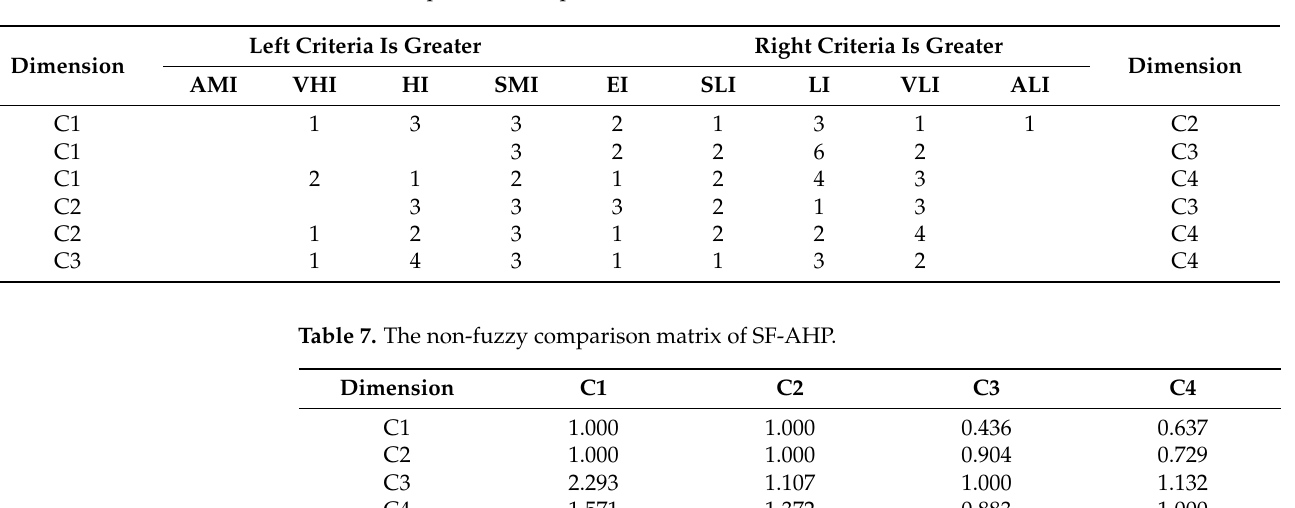
Table 6. The pairwise comparison matrix of SF-AHP.